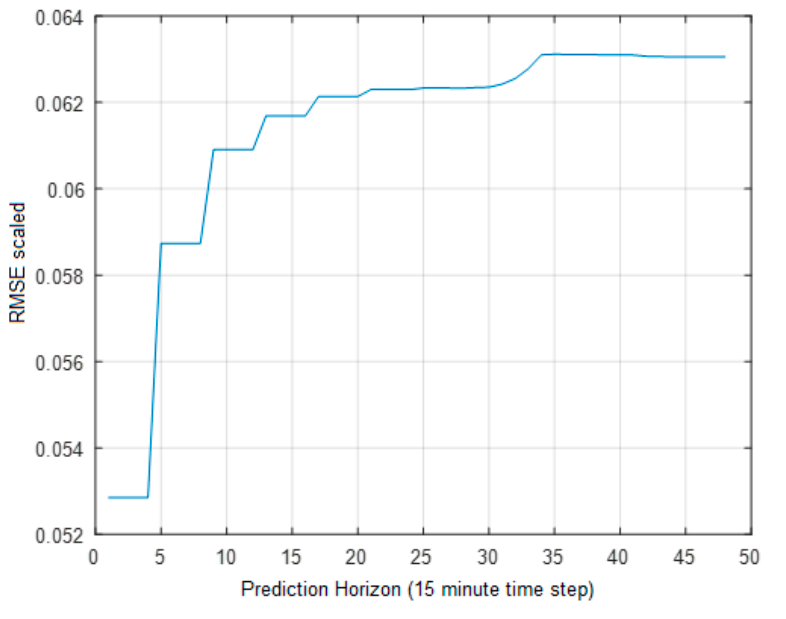
Figure 11. RMSEs of the scaled PV power within the prediction horizon.